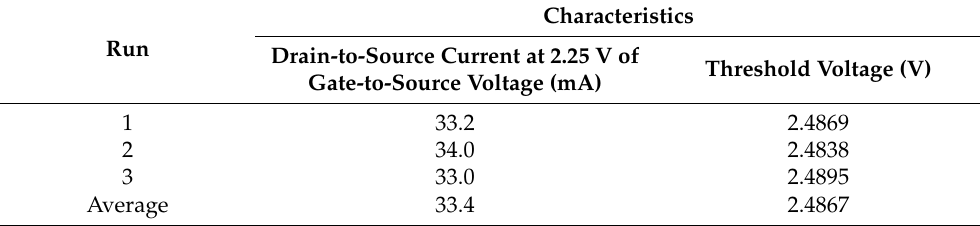
Table 1. Summary of characteristic values of MOSFET after microwave heating.